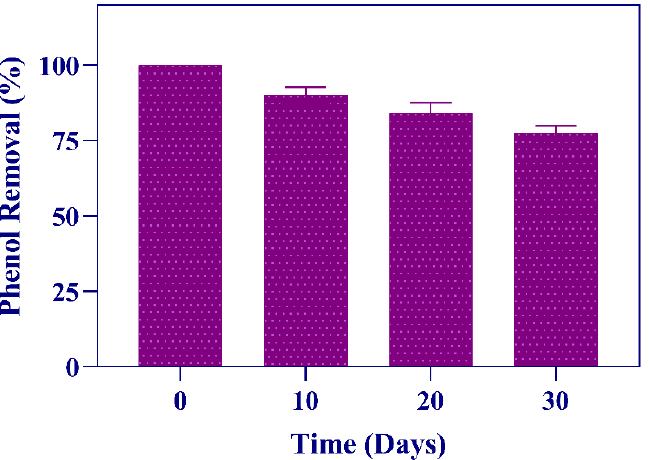
Figure 7. Phenol removal activity of immobilized Sphe3 cells upon storage at 4 °C for 1 month. The activity on the first day was set to 100%. Each reaction cycle was carried out for 48 h. Error bars indicate standard deviation of three measurements.